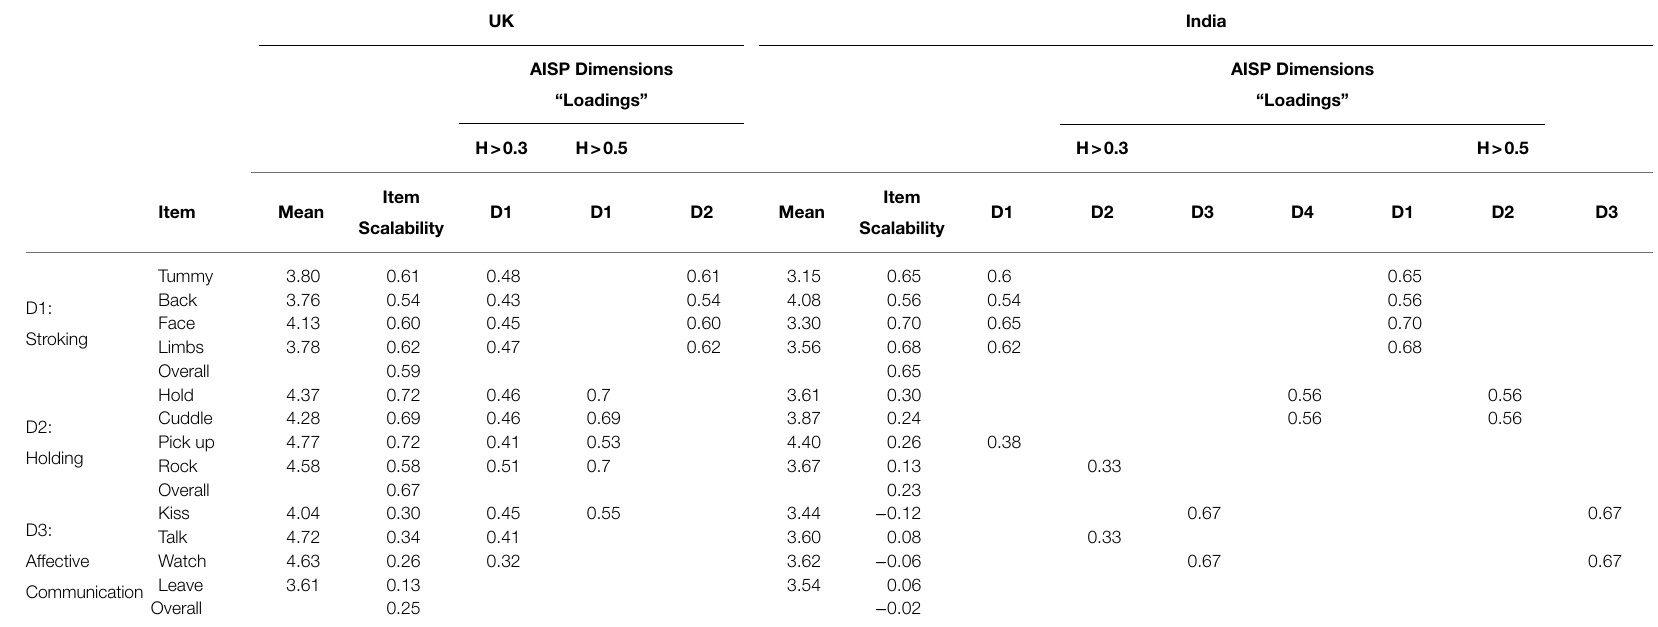
TABLE 3 | Mean response, scalability coefficients (Loevinger’s H), and Dimension Loadings (D) for weak (H > 0.3) and strong (H > 0.5) scale requirements for the United Kingdom (one and two dimension solutions) and Indian cohorts (three and four dimension solutions) as identified by Mokken automated item scale procedure (AISP). UK